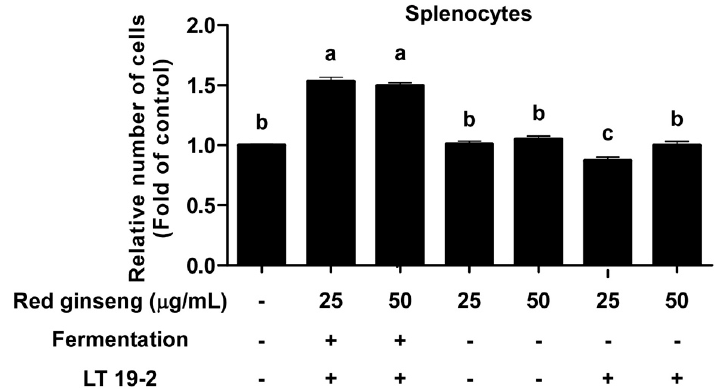
Figure 6. The e ff ect of FRG on splenocyte proliferation. Splenocyte cells were isolated from mice and seeded in a 96-well plate. Celltiter-glo luminescent cell viability assay were performed 48 h after